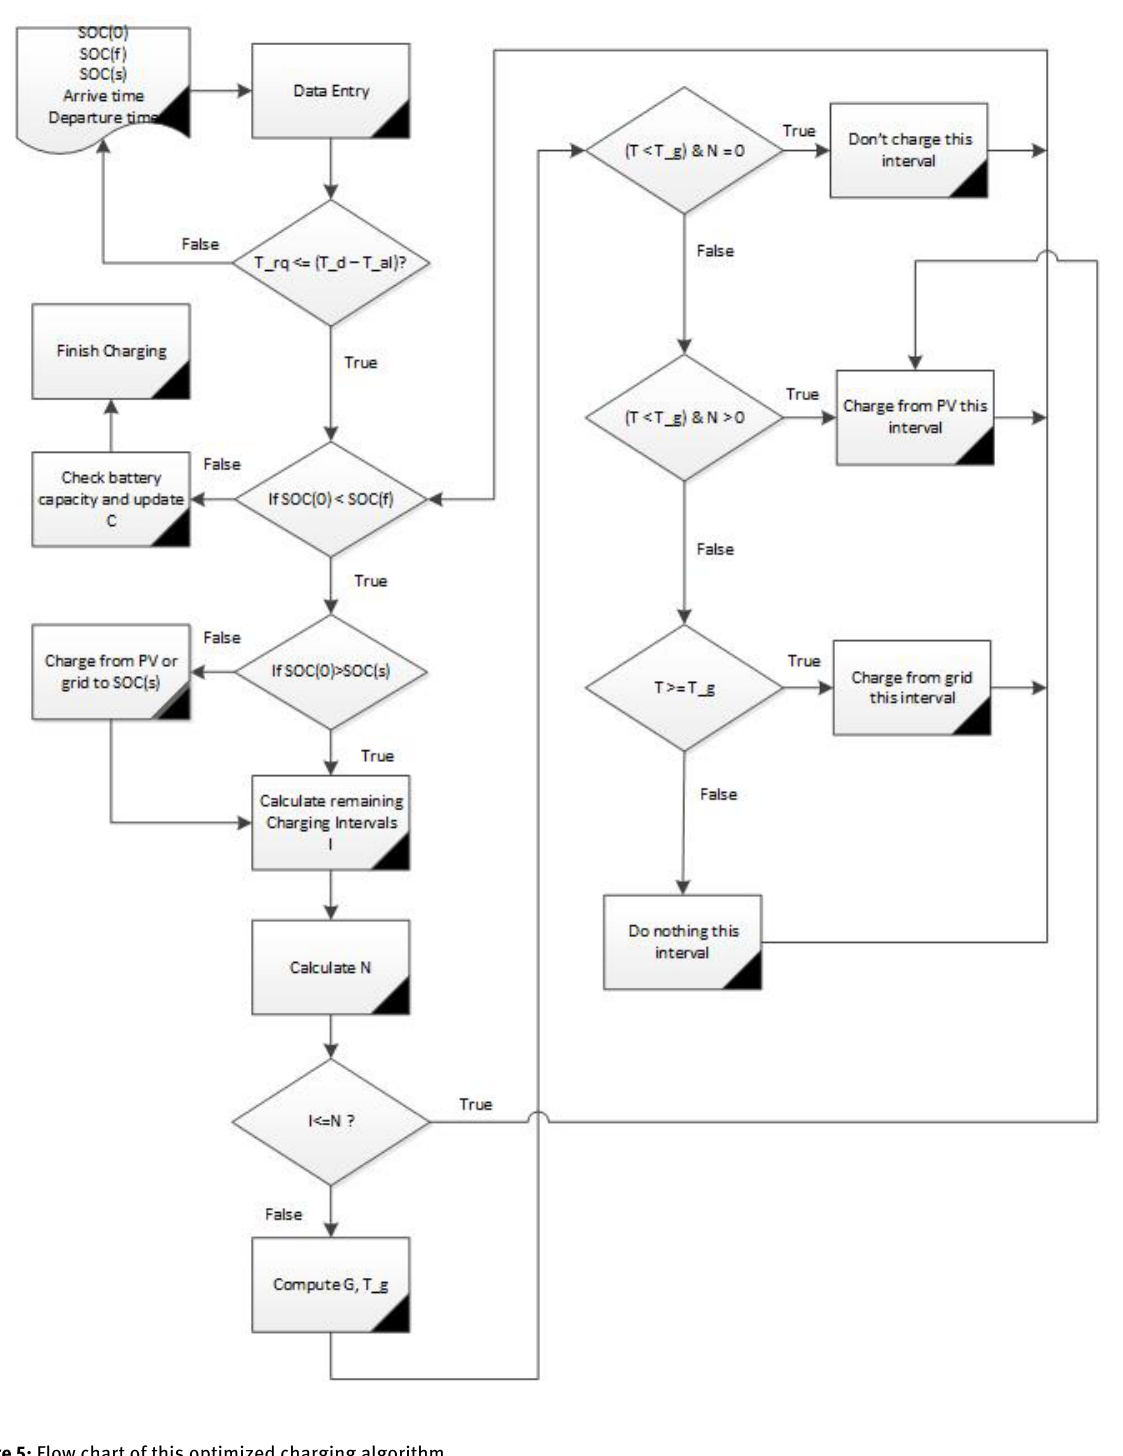
Figure 5: Flow chart of this optimized charging